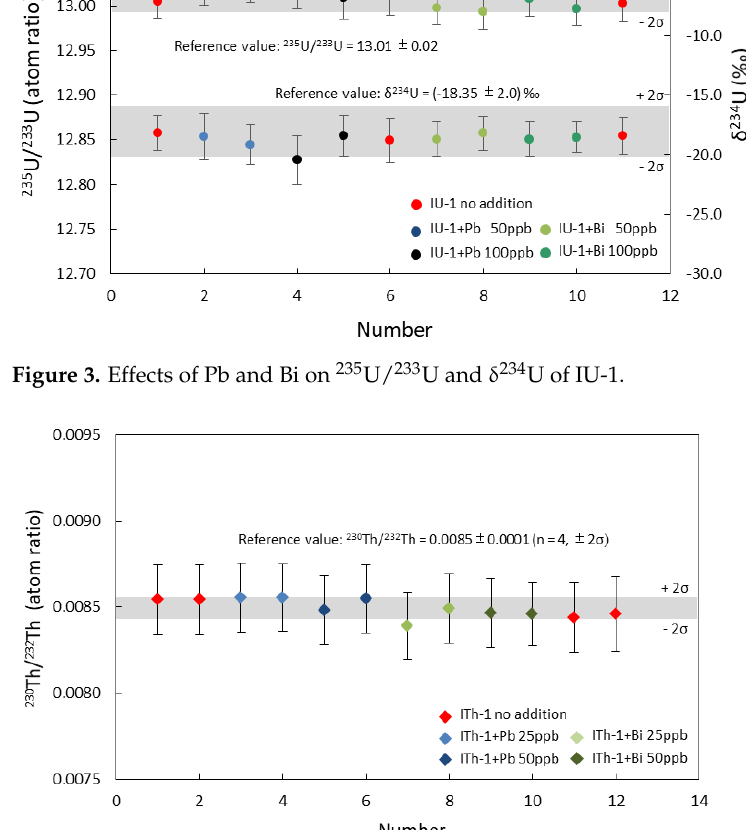
Figure 4. Effects of Pb and Bi on 230 Th/ 232 Th isotopic ratio of ITh-1.